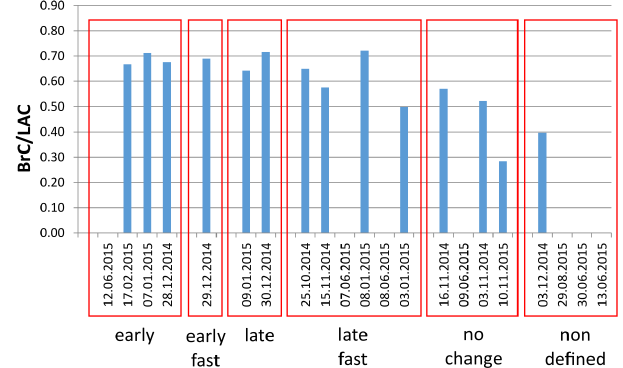
Figure 8. Comparison of BrC / LAC with the categories represent- ing the behavior of the Raman signal during the heating procedure of the thermal–optical analysis. For samples with BrC / LAC = 0 (i.e., no bar in the diagram), BrC was below the detection limit ( < 12.7µgcm − 2